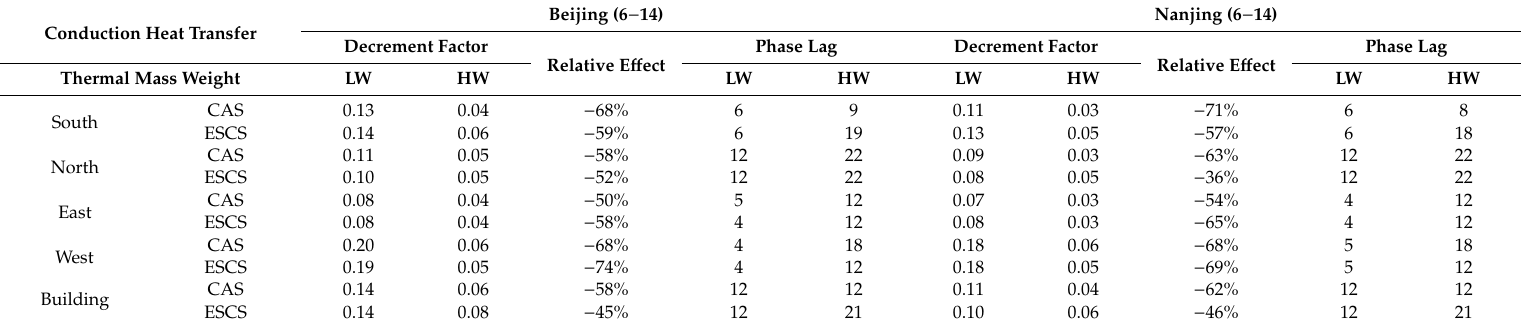
Table 3. The e ff ects of thermal mass on thermal transmission (typical days in transient